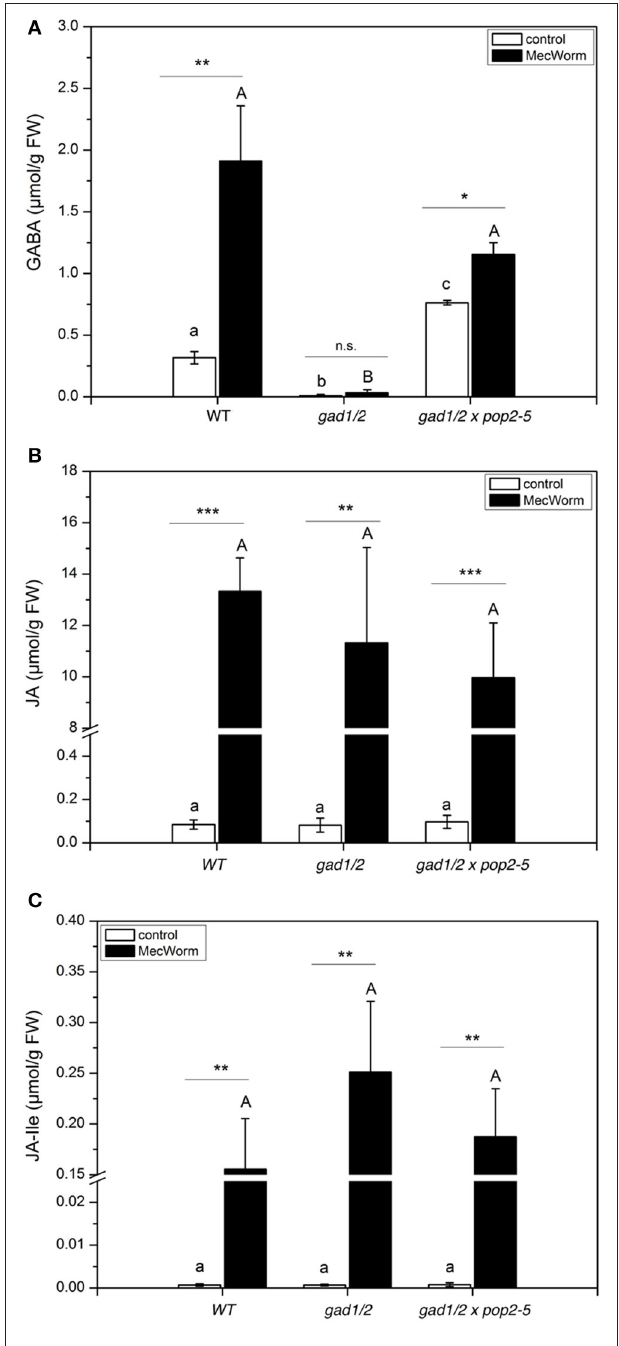
FIGURE 5 | GABA and Jasmonate levels upon Spodoptera littoralis herbivory in Arabidopsis wild-type (WT), gad1/2 and gad1/2 x pop2-5 plants. Mean ( ± SE, n = 10 ) levels of GABA (A) , JA (B) , and JA-Ile (C) in Col-0 WT, gad1/2 (gray) and gad1/2 x pop2-5 (black) plants after S. littoralis feeding (2nd instar) for 1 and 3h. Hormone and GABA levels were measured only from local S. littoralis fed leaves. Untreated leaves from untreated plants were used as controls. Statistically significant differences between hormones in WT and GABA mutant plants after feeding were analyzed by One-way ANOVA ( p < 0.05 , SNK-test) and are indicated by different letters.